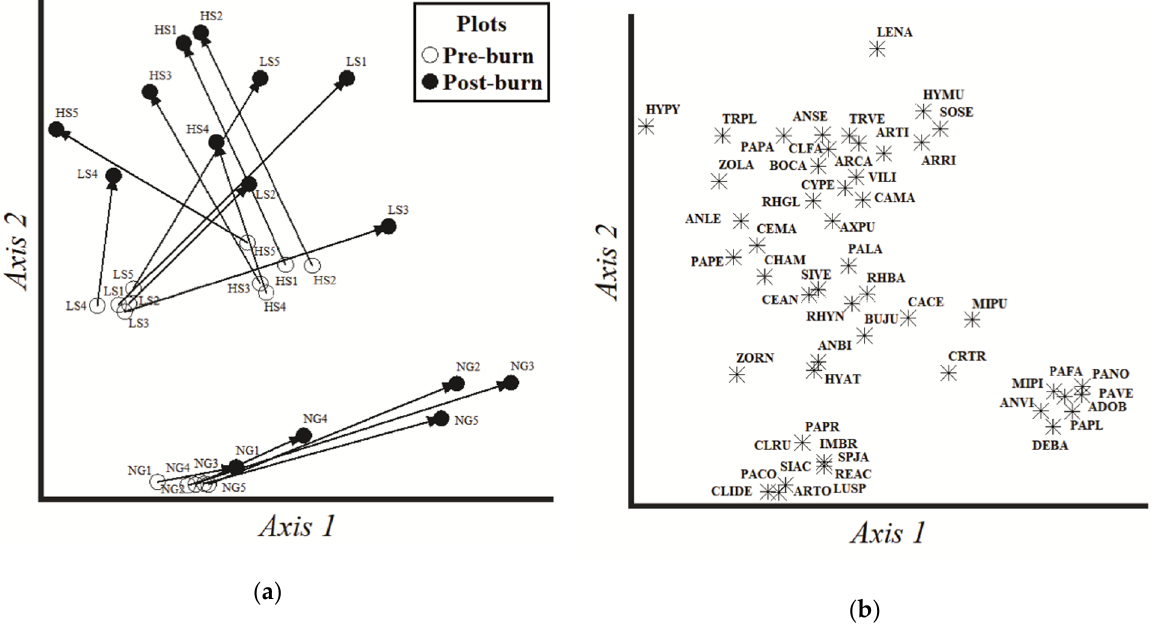
Figure 4. Plot ( a ) and plant species ( b ) ordination by non-metric multidimensional scaling (NMDS) based on a matrix of vascular plant species cover, comparing the pre- ( t 0) and the last post-burn ( t 4) surveys in every grazing treatment. Vectors show the magnitude and the direction of changes between times for the same plot. NG = non-grazed, LS = low stocking rate, HS = high stocking rate. Species codes appear in Table S1.